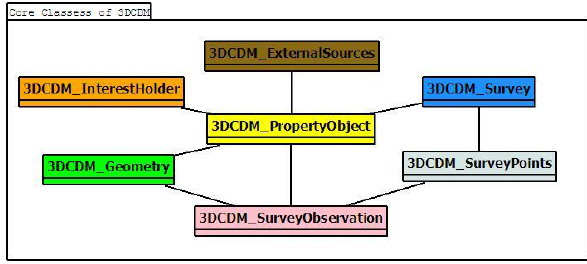
Figure 3. Core classes of 3DCDM